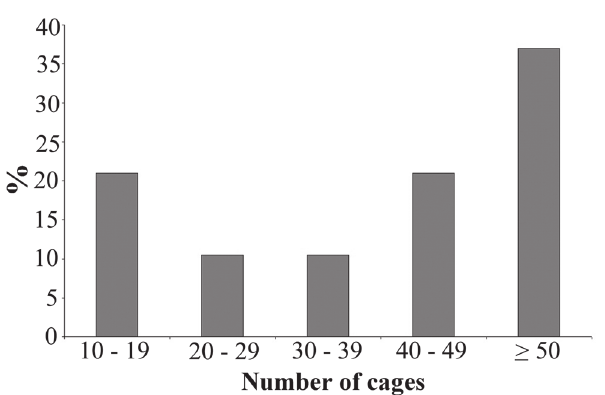
Fig. 2. Frequency of fish farmers (%) operating different number of cages in Furnas Reservoir (n = 19).